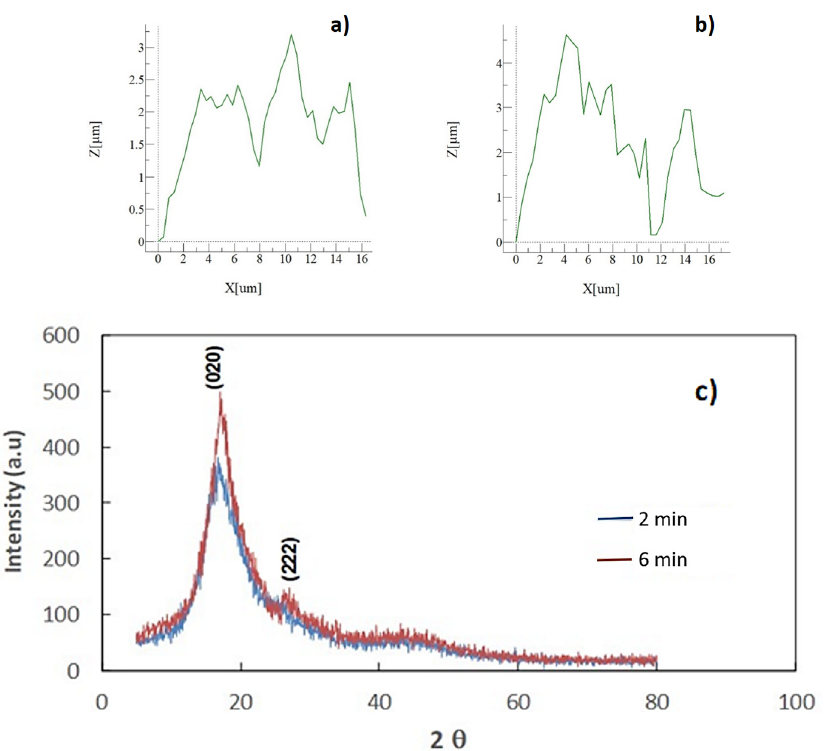
Figure 2. Atomic force microscopy line scan over treated surfaces: ( a ) line scan for 2 min treated surface, ( b ) line scan for 6 min treated surface, and ( c ) X-ray diffraction (XRD) data for crystallized treated surface for 2 and 6 min.